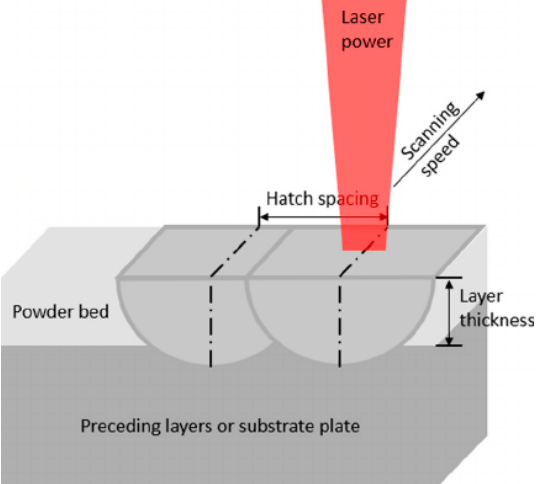
Figure 1. Schematic diagram of the selective laser melting (SLM) process.